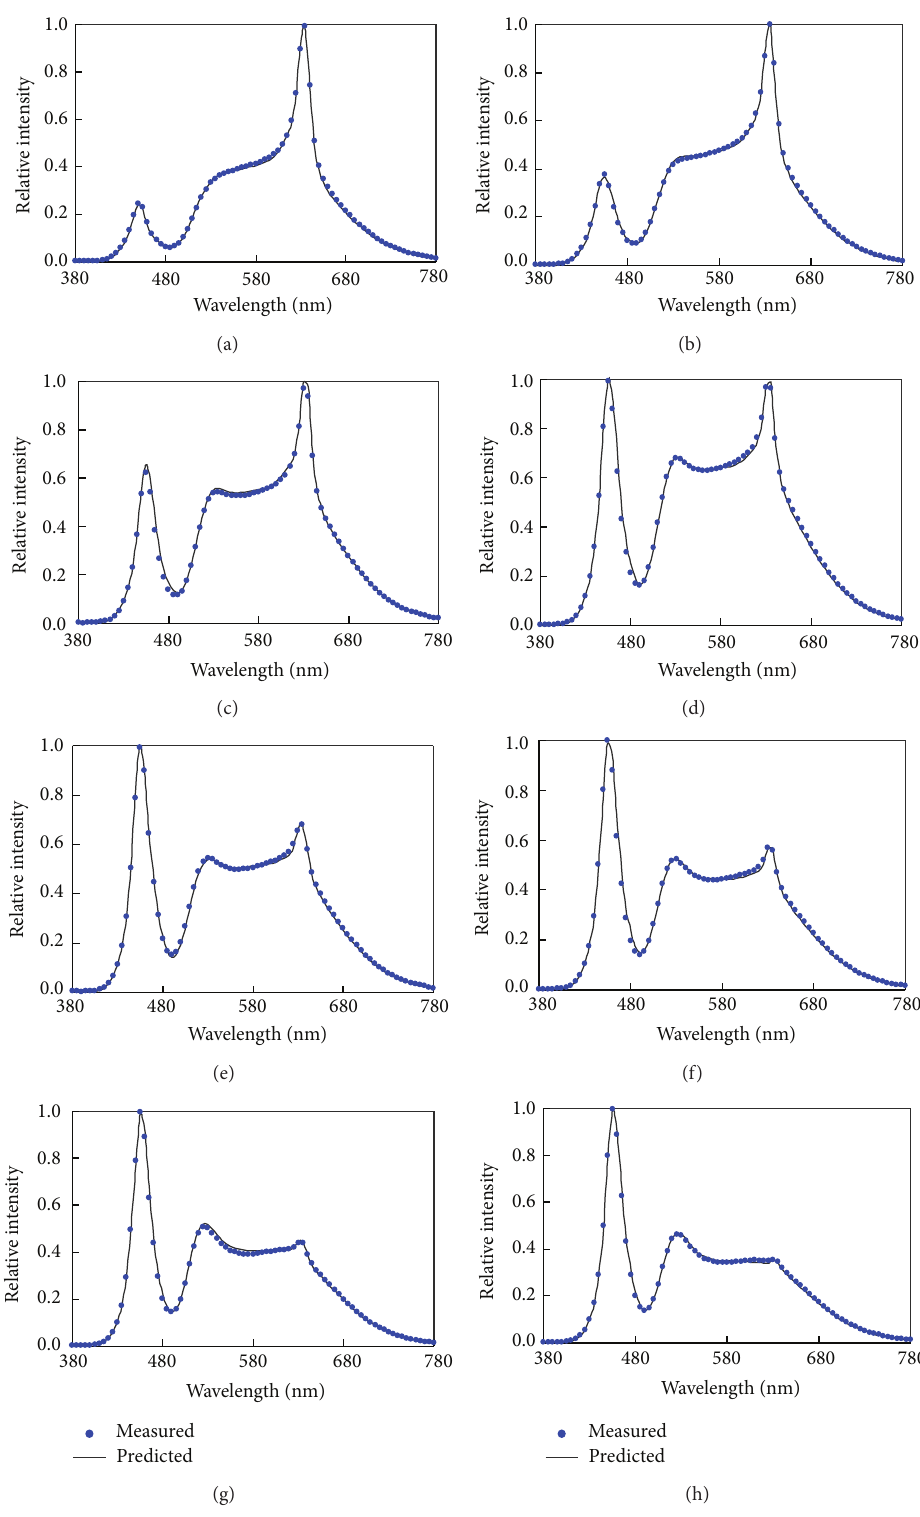
Figure 3: Predicted and measured SPDs of the white light-LED cluster at different CCTs: (a) CCT = 2719 K; (b) CCT = 3028 K; (c) CCT = 3458 K; (d) CCT = 3983 K; (e) CCT = 4537 K; (f) CCT = 5012 K; (g) CCT = 5723 K; (h) CCT = 6497